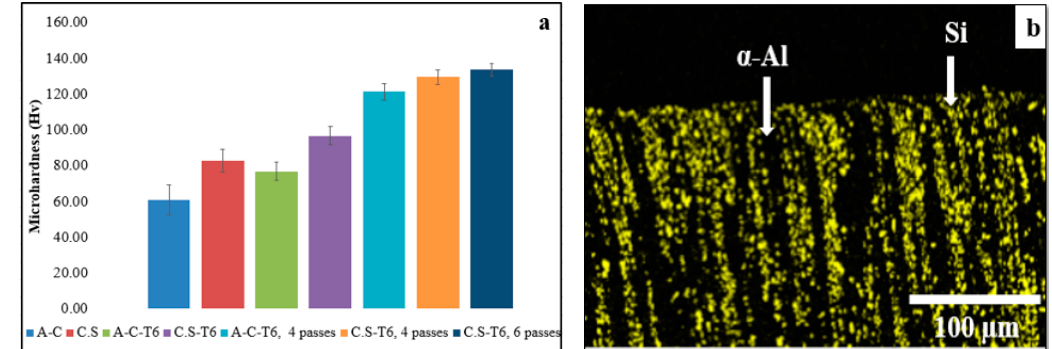
Figure 6. ( a ) Effect of T6 heat treatment and ECAP process on hardness of A356 alloy and ( b ) Mapping of silicon particles distribution in ECAPed samples.